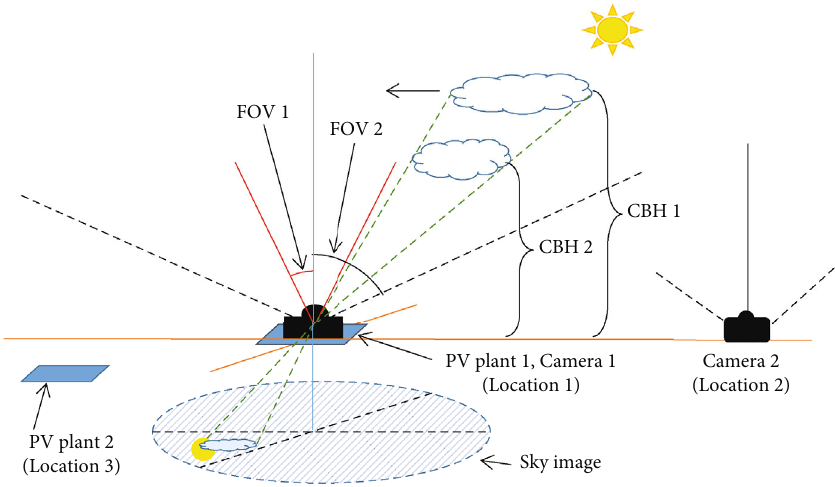
Figure 1: Camera locations, di ff erent FOVs of a camera, and how it captures clouds with two